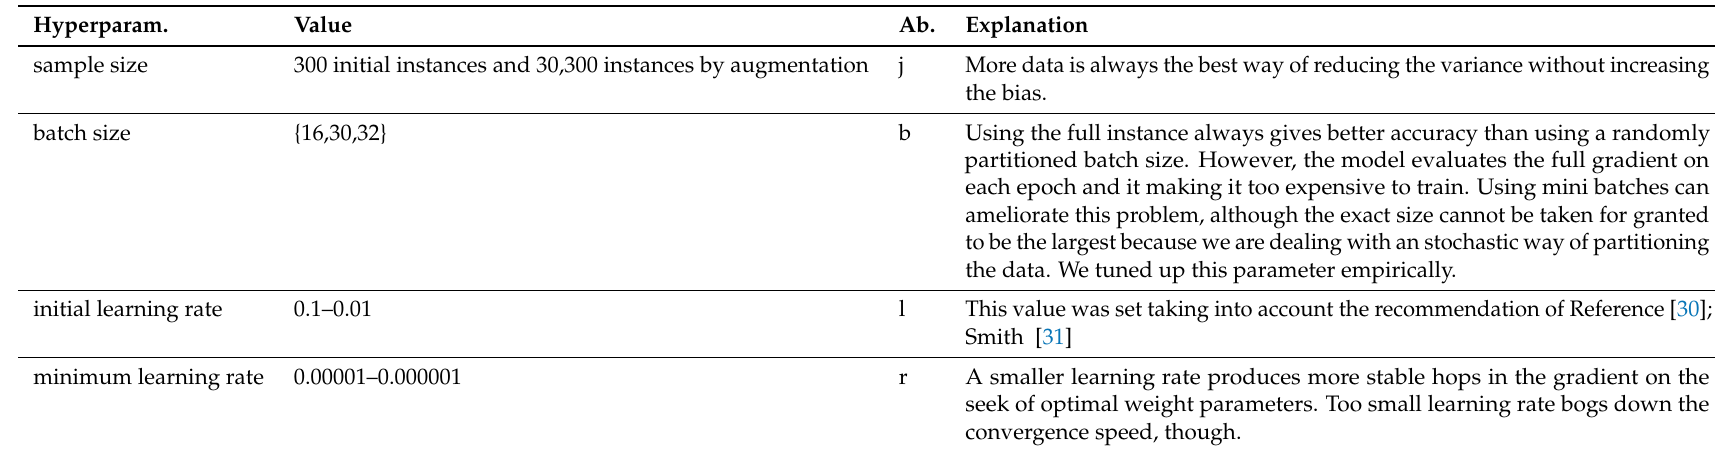
Table 2. Hyperparameter experimental